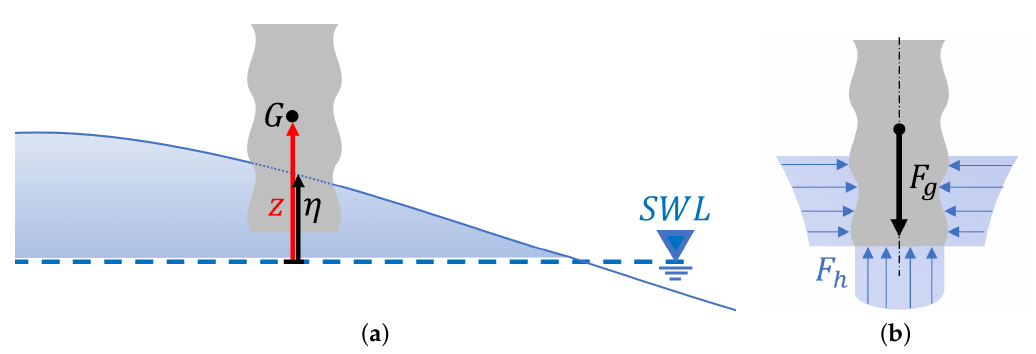
Figure 1. ( a ) Schematic view of the buoy; ( b ) free-body